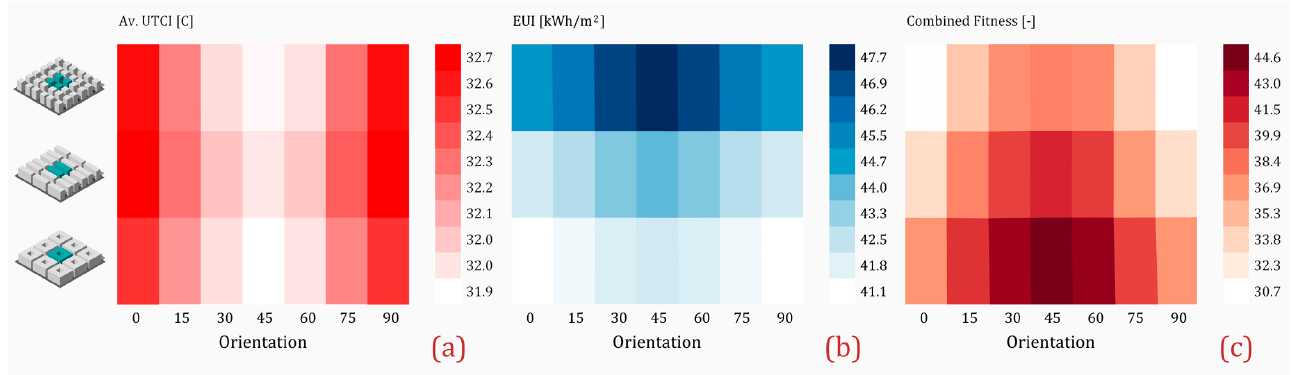
Figure 5. Performance evaluation of the three typologies in different orientations in terms of ( a ) AV.UTCI, ( b ) EUI, and ( c ) combined fitness.